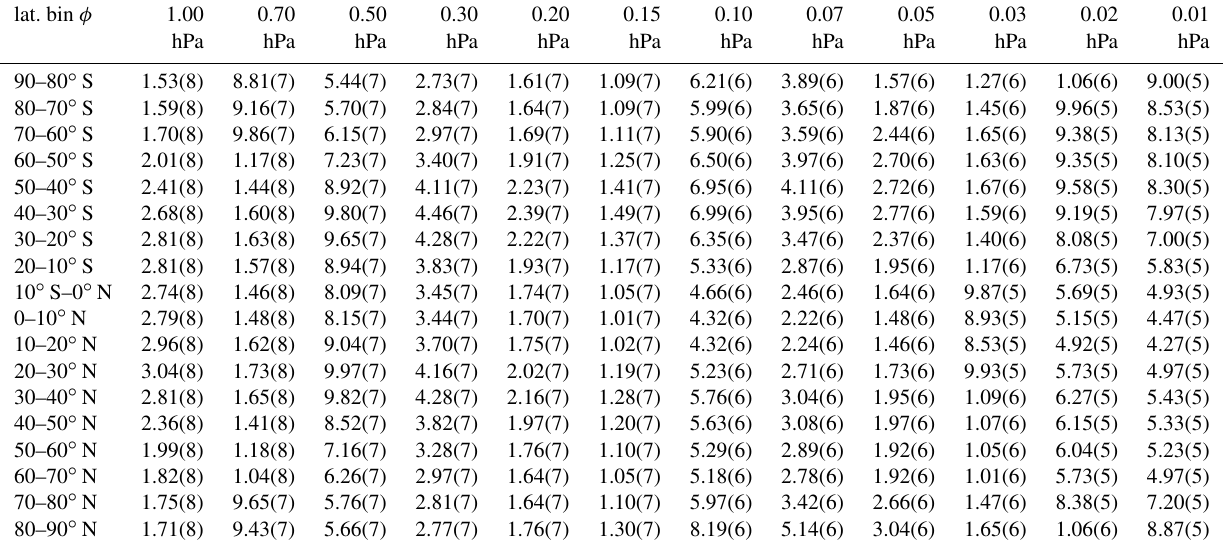
Table B1. Coefficients a 0 (φ,z) in units of cm − 3 . Values in parentheses should be read as powers of 10. lat. bin φ